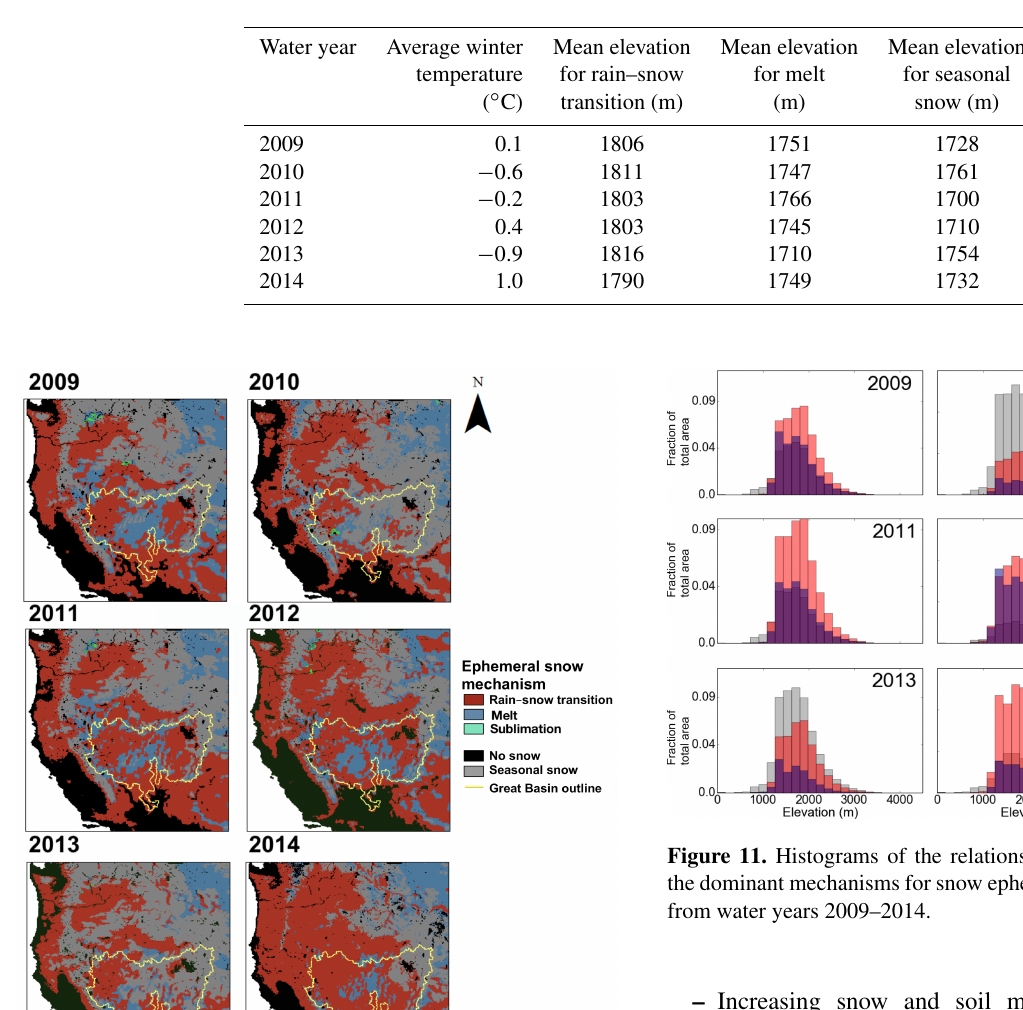
Table 1. Average winter (1 December–1 April) temperature ( ◦ C) and average elevation (m) for both dominant mechanisms of snow ephemer- ality and seasonal snow from 2009 to 2014 in the Great Basin.